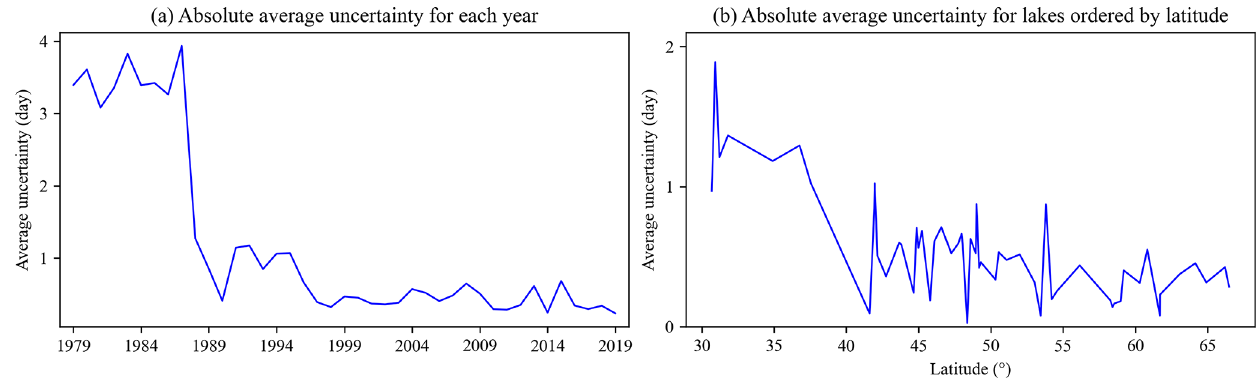
Figure 4. Differences in absolute average uncertainty among years and lakes: (a) absolute average uncertainty for each year and (b) absolute average uncertainty of lake ice phenology results extracted from SSM/I and SSMIS data for each lake ordered by